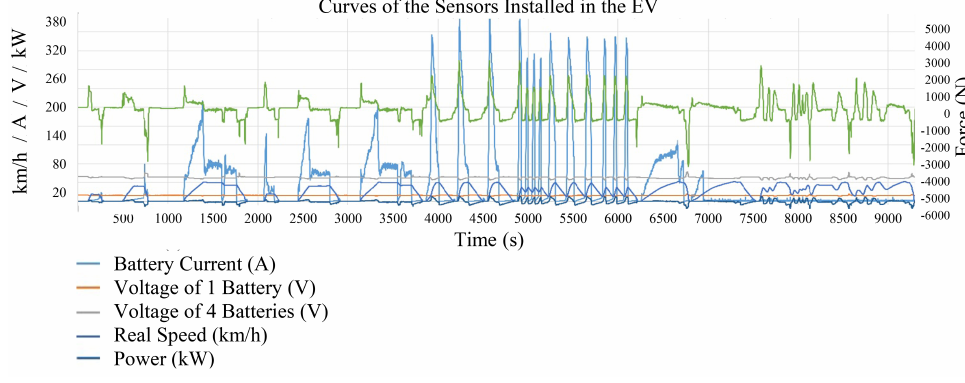
Figure 3. Data from the sensors when the EV is under